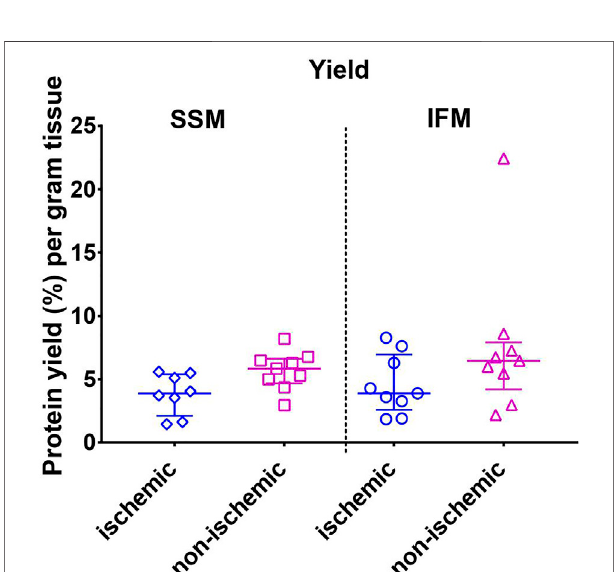
FIGURE 2 | Mitochondrial protein yield as measured by the Bradford assay. Values are represented as median with interquartile range ( n = 10/ group). No signi fi cant differences were found among the four groups. For exact p -values of all group comparisons, please refer to Table 2 .